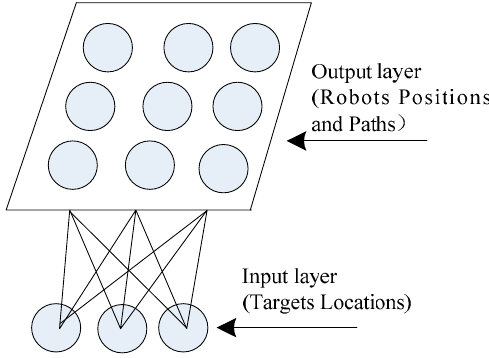
Figure 1. Self-organizing map (SOM) structure of a multi-robot system.